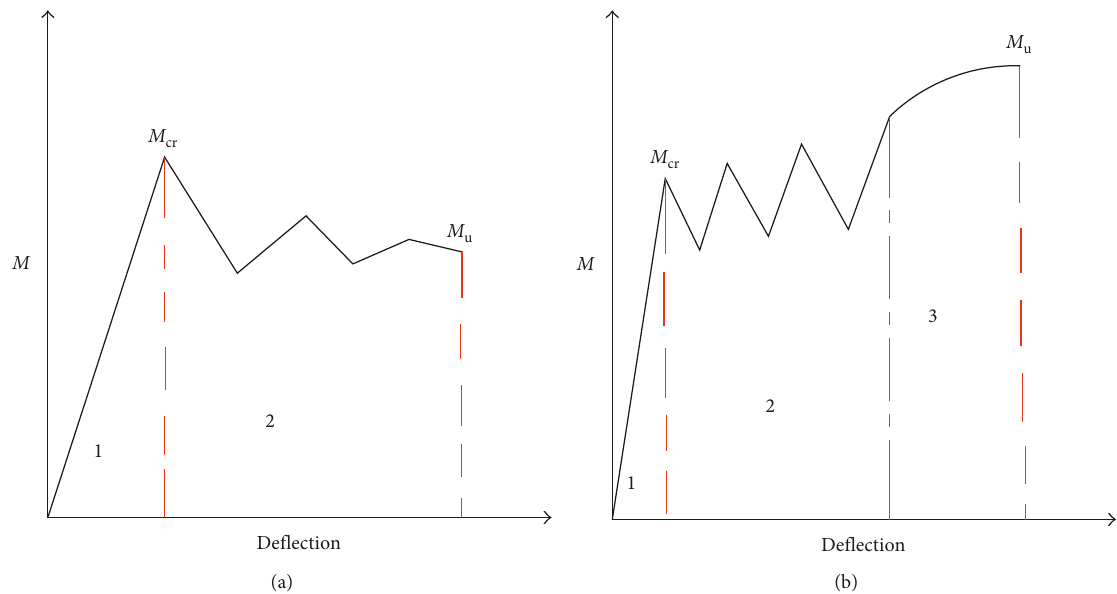
Figure 48: Failure process of the stone slab with NSM screw-thread steels: (a) brittle failure mode and (b) ductility failure mode.